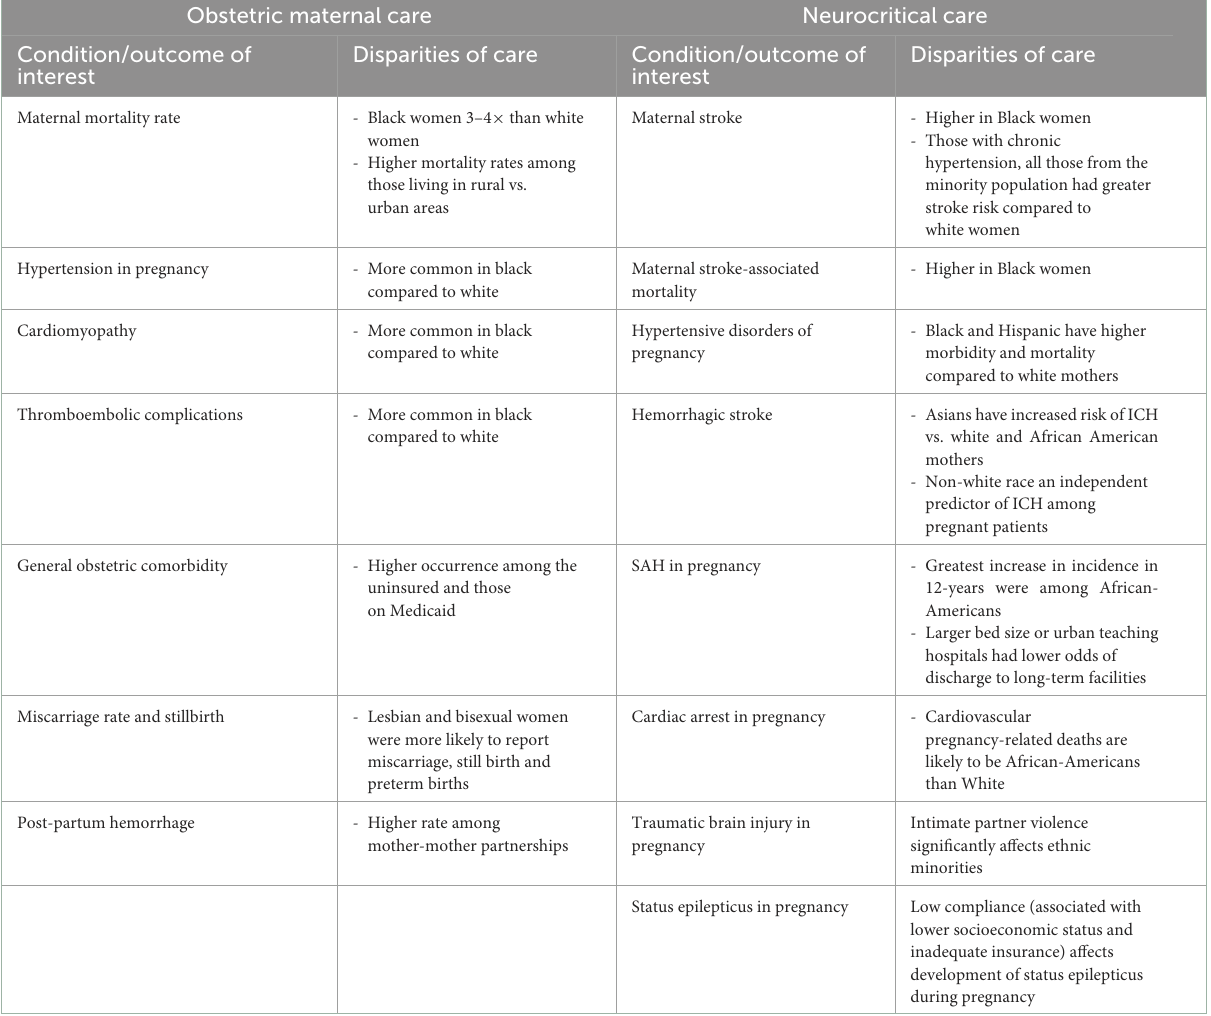
TABLE 1 Summary of areas of disparities in obstetric care and neurocritical